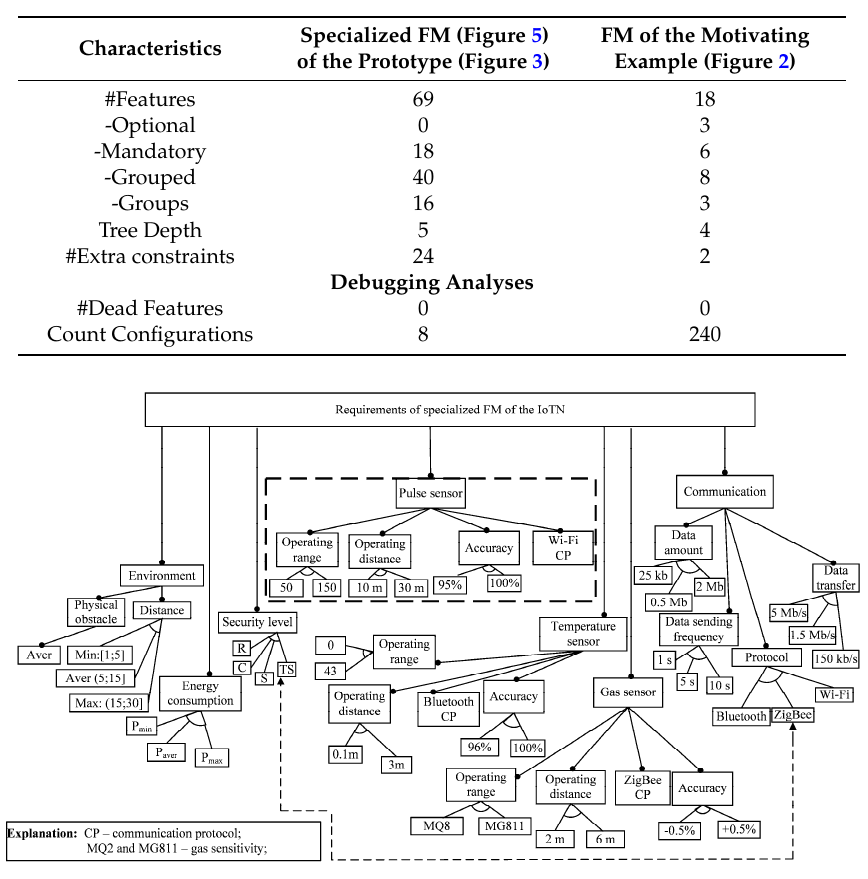
Figure 5. Specialized concrete feature model to specify generic requirements for a set of BAN applications. Table 1. Constraint relationships within the feature model (Figure 5).